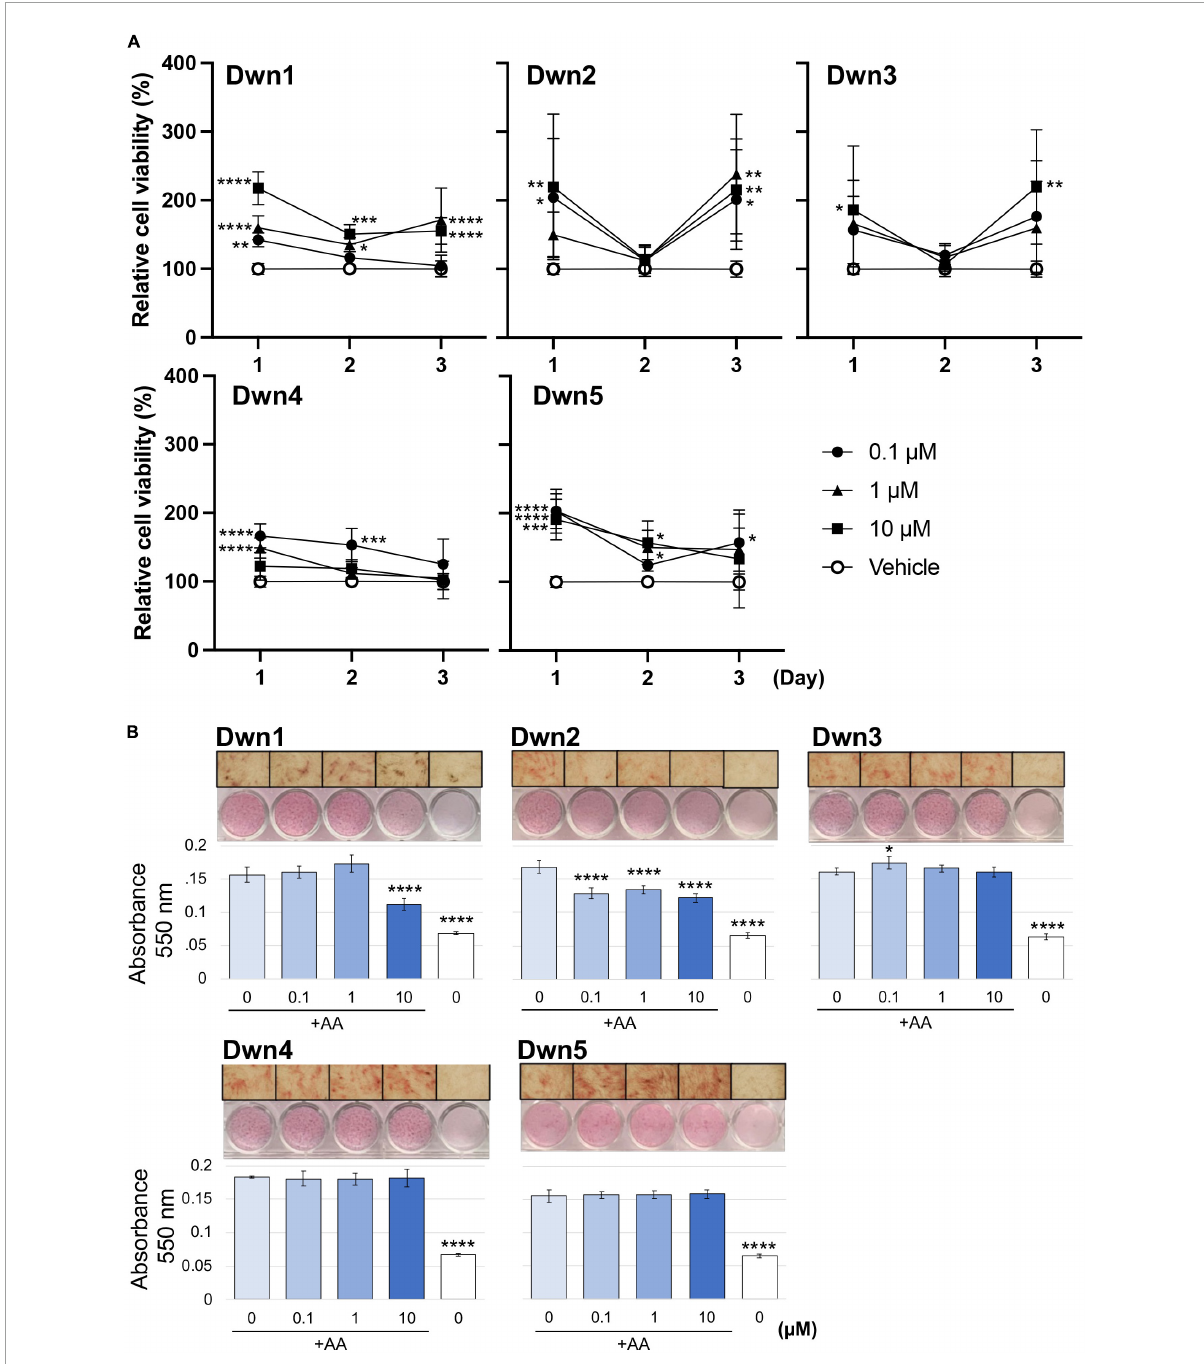
FIGURE1 Cell viability and collagen synthesis after hit compound treatment. (A) Cellular viability was analyzed using a WST-1 assay, showing the percentage of the relative cell viability under each hit compound compared with vehicle-treated cells ( N = 5). Analysis consisted of Dunnet’s Test and two-way ANOVA (* P < 0.05, ** P < 0.01, *** P < 0.001, **** P < 0.0001; significant difference determined in comparison to vehicle control; bars representative of standard deviation). (B) Absorbance values were calculated from spectrophotometer data after picrosirius red staining of human dermal fibroblasts (HDFa). Higher levels of total collagen expression elicited higher absorbance values due to the red staining. Images were taken on D14 and can be seen above each respective graph. The positive control was the 0 µ M group cultured with AA supplementation in the growth medium. The negative control was the 0 µ M group treated cultured without AA supplementation ( N = 4). Analysis consisted of one-way ANOVA and Dunnet’s Test (**** P < 0.0001; significant difference determined in comparison to 0 µ M with AA group; bars representative of standard deviation). The x-axis indicates hit compound concentrations while the black underscore indicates which groups contained AA